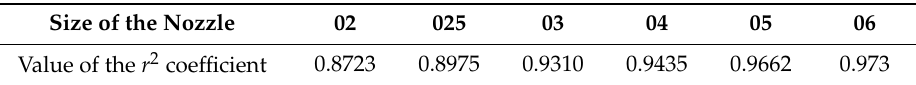
Table 2. The values of correlation and determination coe ffi cient for the E ˙ZKT